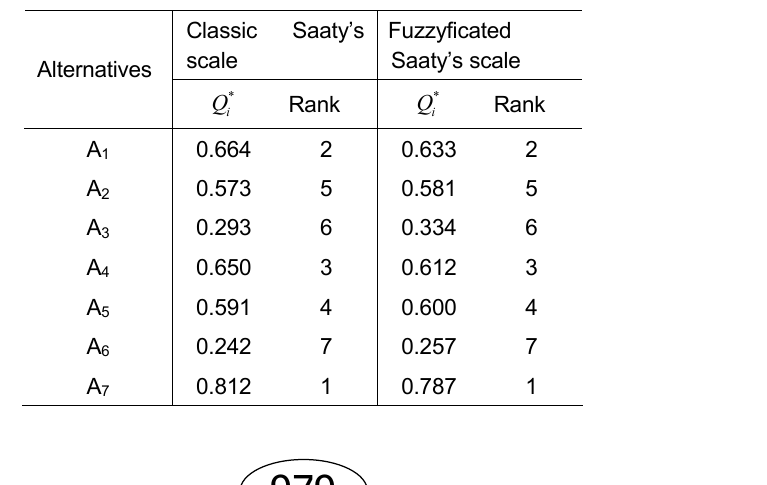
Table 3 – Comparative summary of the solutions Таблица 3 – Сравнительный обзор решений Tabela 3 – Upredni pregled dobijenih